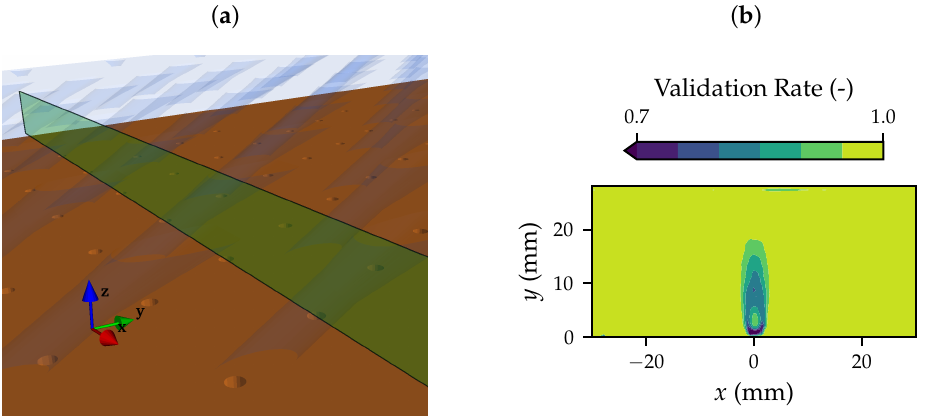
Figure 4. ( a ) Light sheet arrangement in the cavity. Impingement specimen in brown, effusion specimen in blue. Center sheet location relative to impingement hole for MALO00 case. ( b ) Validation rate for a worst case scenario 7D-MALO00 , high Re D, imp , center